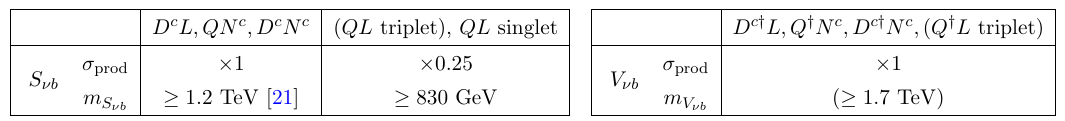
Table 3 . 95% CL lower limits on the masses of MLQs which decay into ( (cid:23)b )( (cid:23)b ) (cid:12)nal states for the scalar LQs ( left ) and vector MLQs ( right ).